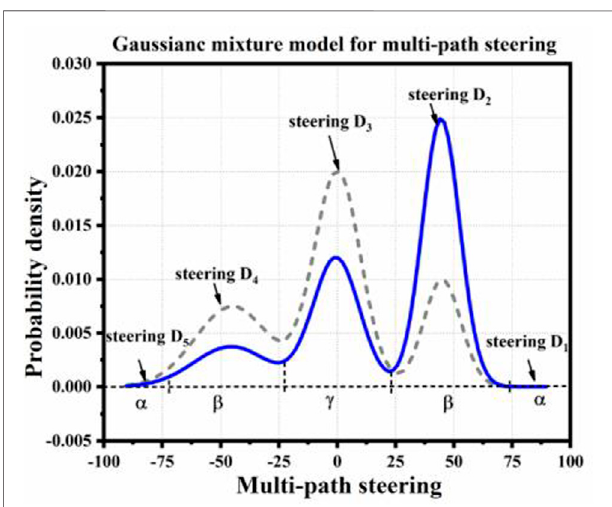
FIGURE 23 | Newly generated steering distribution after rejecting